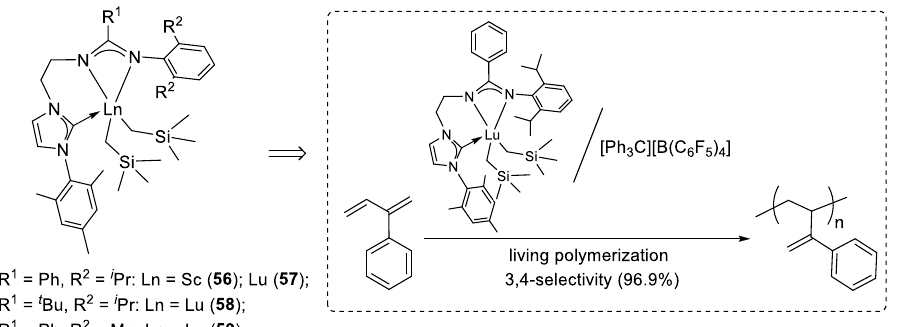
Figure 14. The amidino-NHC ligand-supported Ln complexes used for polymerization of 2-phenyl- 1,3-butadiene.